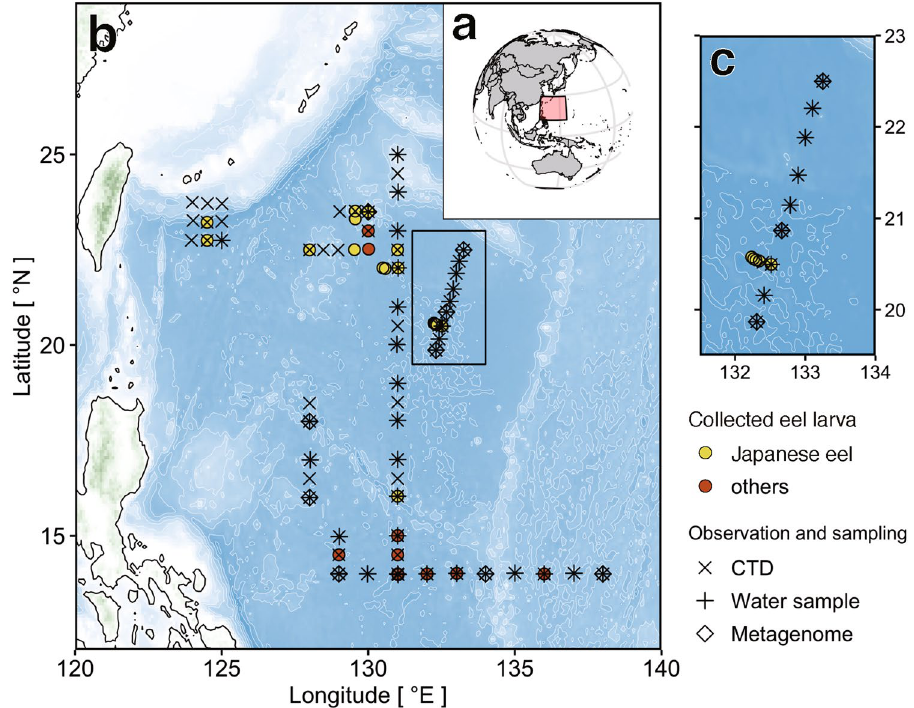
Figure 1. Sampling map. Overview map of the sampling and survey stations in the tropical and subtropical western North Pacific. The pink square indicates our research area on the global map ( a ). Enlarged views of the research area ( b , c ). Circles denote stations where eel larvae were collected (yellow circles: larvae of Japanese eel, red circles: other larvae). Cross (×), plus (+), and diamond ( ◇ ) indicate CTD observation, water sample collection points for analysis of marine environments and phytoplankton, and water sample collection points for metagenome analysis, respectively. Location data of all stations are available in Supplementary Table 1. The map was generated using the marmap package (version 1.0.3) in R with data imported from the NOAA server (accessed on 5 December 2019).